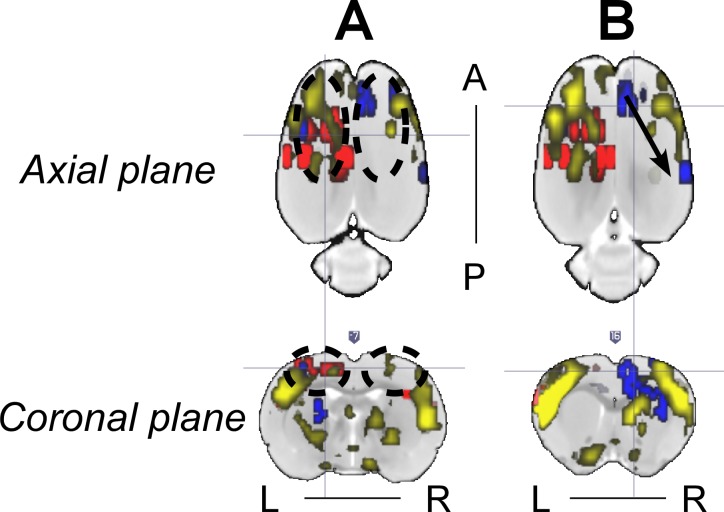
Representative relationship between the IED-evoked BOLD responses and RSN from Rat 2.(A) and (B) show two different axial and coronal slices with IED-evoked BOLD responses overlapped with RSN. RSN’s symmetry was disturbed in (A) due to the existence of two IED-evoked BOLD responses (black dash circles). Overlap between RSNs and IED-evoked BOLD responses exists preferentially on the left hemisphere. (B) Distant IED-evoked BOLD responses are connected by RSN (black arrow). IED = interictal epileptiform discharge; BOLD = blood-oxygen-level dependent; RSN = resting-state network; R = right; L = left; A = anterior; P = posterior.